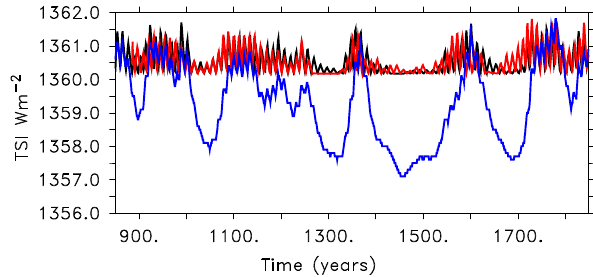
Figure 3. Reconstructions of total solar irradiance based on two different isotope data sets and two different irradiance models. The 14 C-based reconstruction of sunspot numbers is converted to TSI using (black line) the SATIRE-M model and (blue line) the updated Shapiro et al. (2011) model. The 10 Be-based TSI reconstruction is constructed using the SATIRE-M model (red